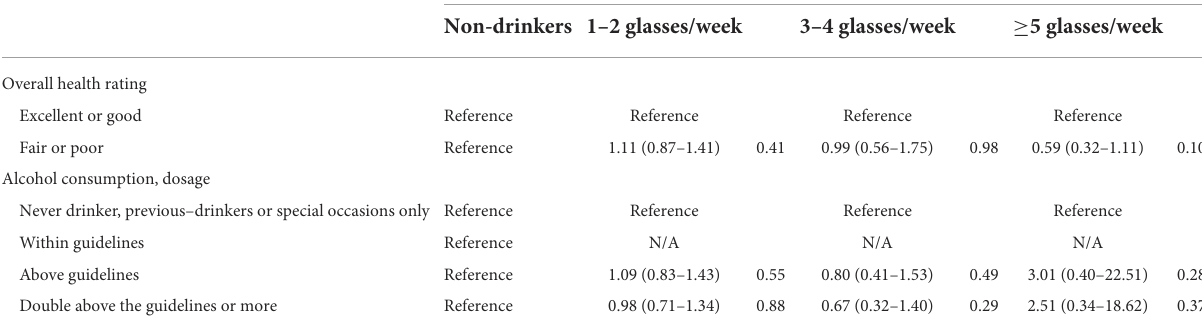
TABLE 11 Odds ratios and 95% CIs for the interaction effect between fortified wine and risk of IBD.